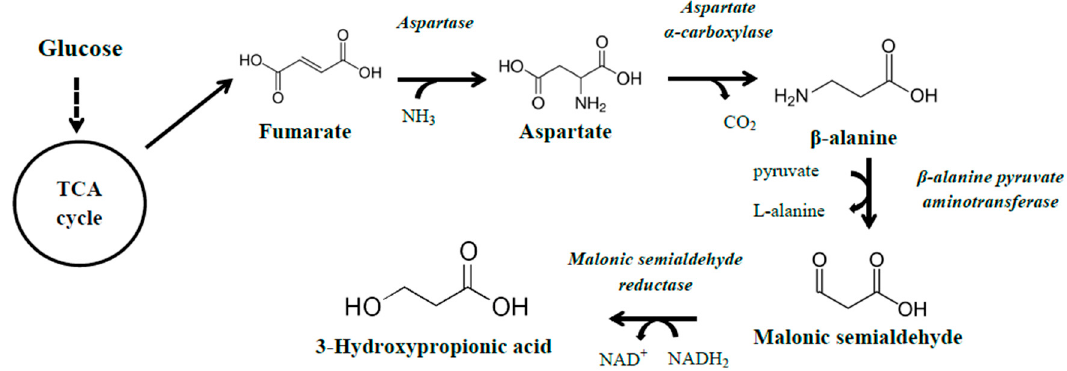
Figure 4. Conversion of glucose to 3HP through the β -alanine pathway.